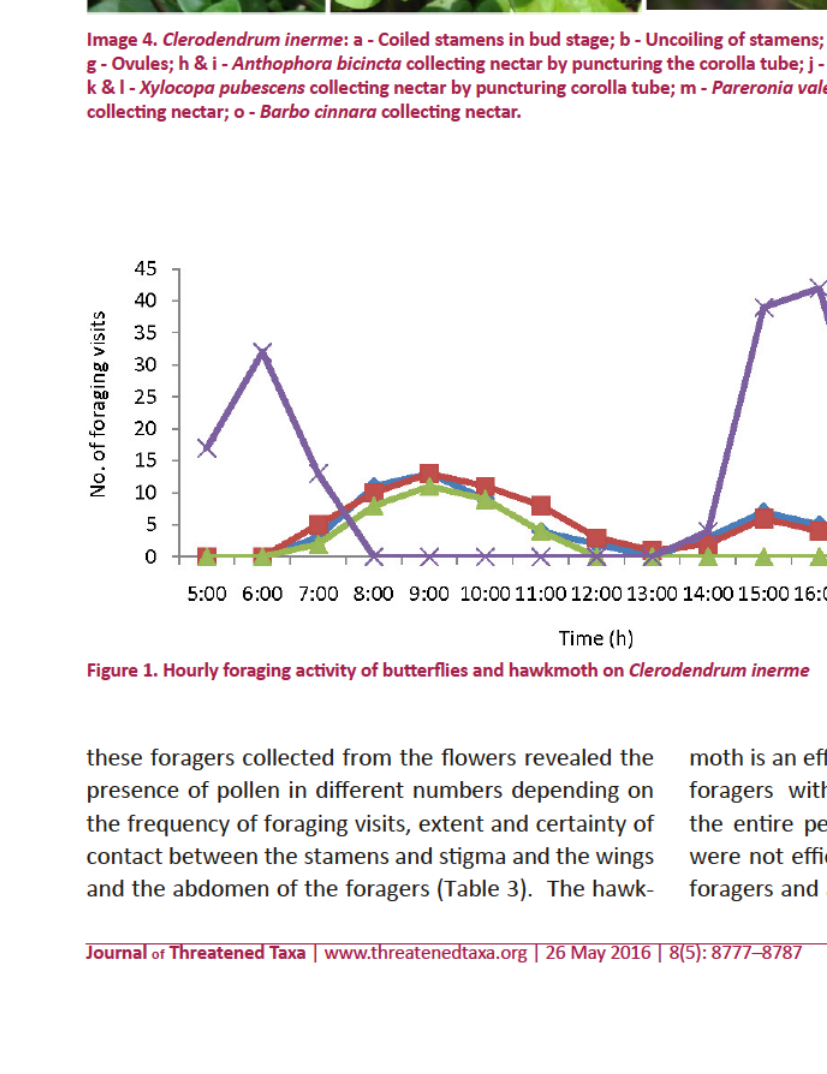
fthese fforagers coflflecfted ffrom fthe flowers reveafled fthe presence off poflflen in differenft numbers depending on fthe ffrequency off fforaging visifts, exftenft and cerftainfty off conftacft beftween fthe sftamens and sigma and fthe wings and fthe abdomen off fthe fforagers (Tabfle 3). The hawk-